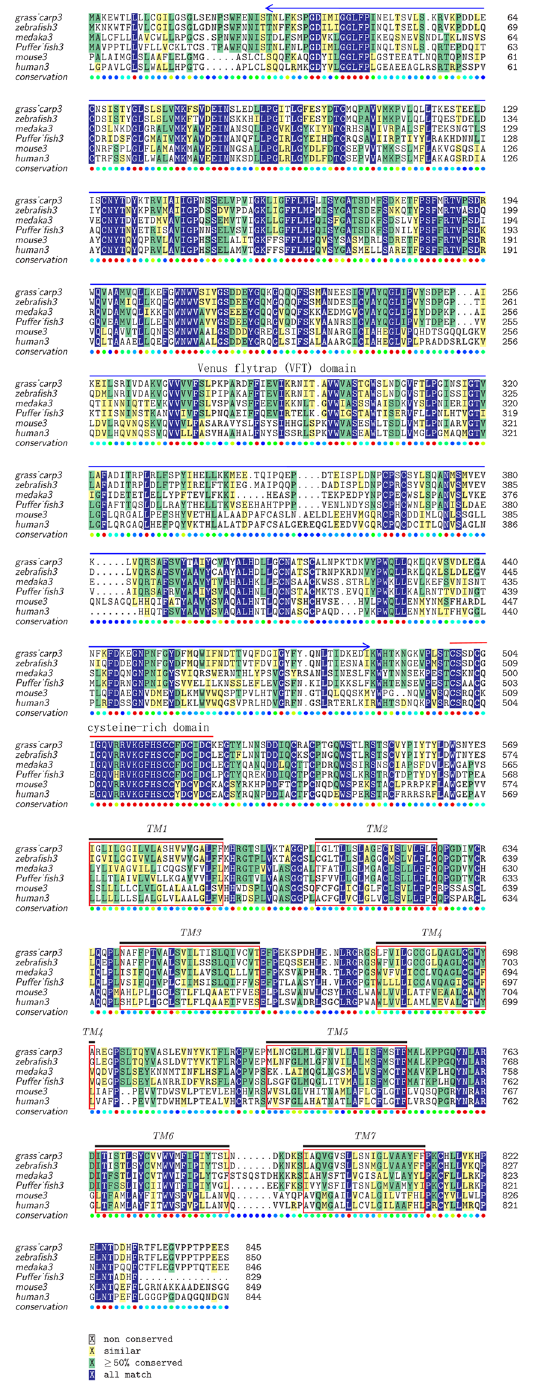
Figure 2. Multiple amino acid sequence alignment of T1R3. The colors indicate that the amino acids in that column were identical across all species. Extracellular amino-terminal domain Venus flytrap module (VFTM) containing the ligand binding pocket was marked with blue line. A cysteine-rich domain (CRD), which links the VFT and 7TM domains was marked with red line. Transmembrane domains (TMD) of grass carp T1R3 were marked with red box. Amino acid sequences are available from the DDBJ/EMBL/GenBank databases shown in Table